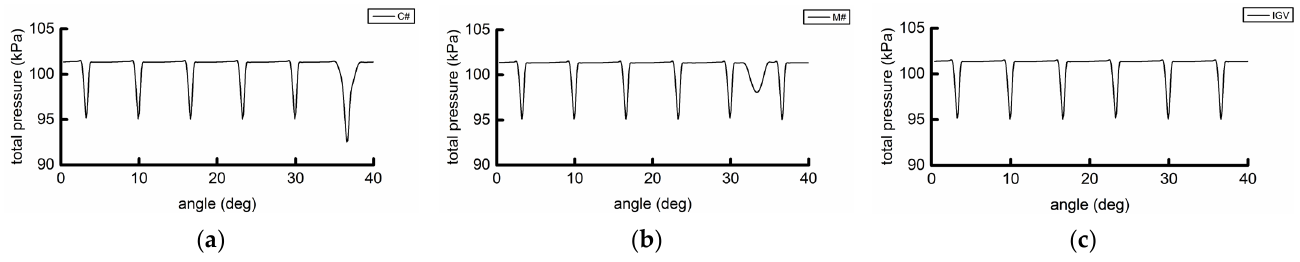
Figure 19. Time-averaged total pressure at 50% blade span at IGV/R1 interface. ( a ) C# ( b ) M# ( c ) IGV.